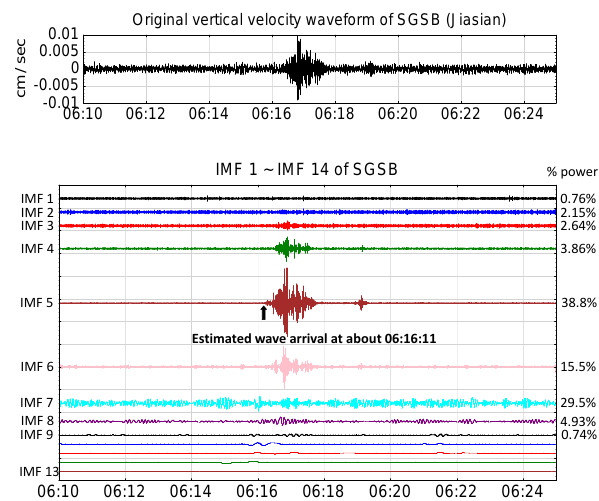
Figure 7 IMFs 1 – 14 of the vertical velocity from the Jiasian SGSB station (06:10 to Fig. 7. IMFs 1–14 of the vertical velocity from the Jiasian SGSB 06:25, August 9, 2009). station (06:10 to 06:25 a.m.LT, 9 August